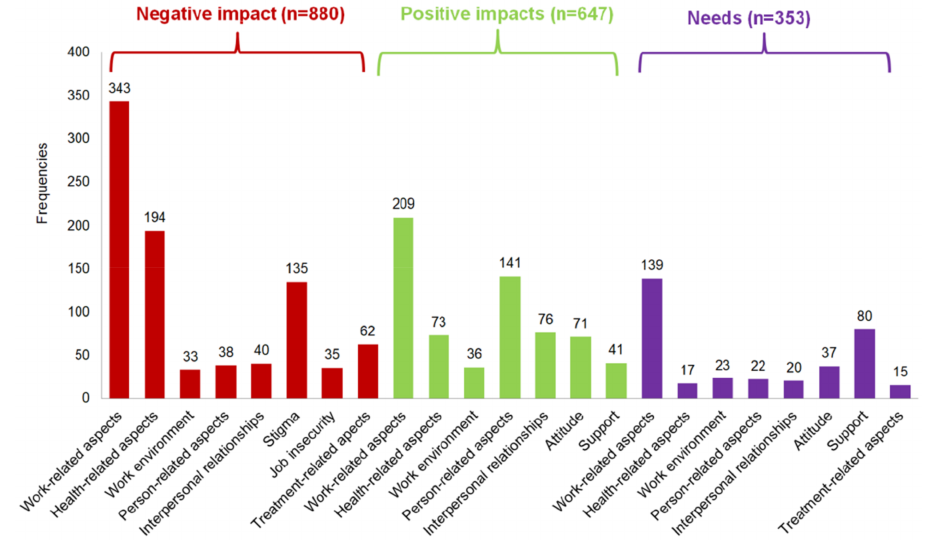
Figure 3. Frequencies of codes in the different themes for the Factors having a negative impact and Factors having a positive impact on work life, as well as the Needs to maintain a job or return to